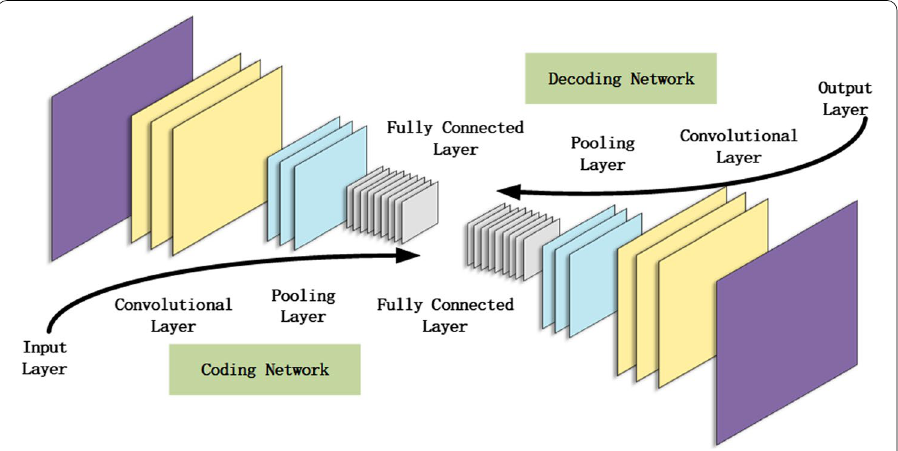
Fig. 4 CAE principle block